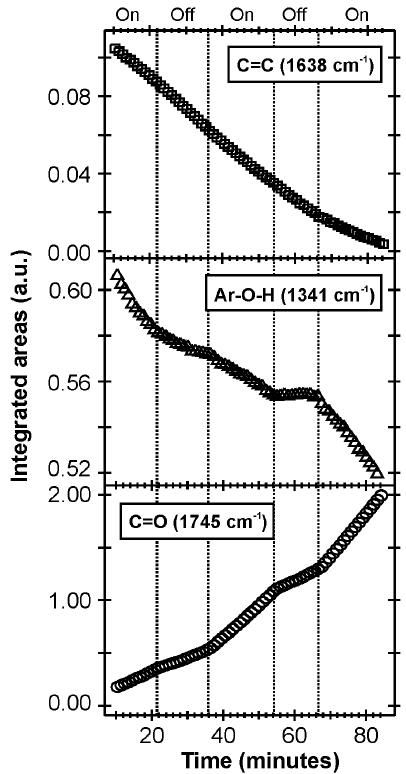
Fig. 9. Reaction kinetics for NaCl-adsorbed eugenol exposed to 495ppb O 3 as a function of UV–visible radiation. Xenon lamp “on” and “off” labels indicate light and dark conditions, respectively. Phenol bend (1341cm − 1 ) and carbonyl (1745cm − 1 ) were photoen- hanced, while the alkene side chain (1638cm − 1 ) was